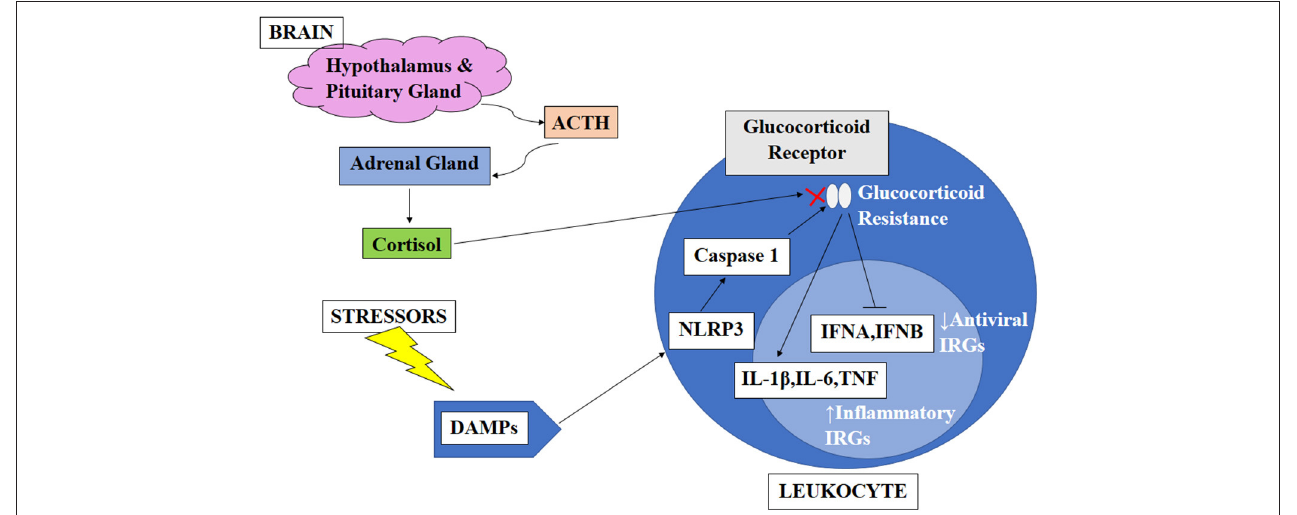
FIGURE 2 | Schematic diagram on the cascading pattern of circadian disruption resulting in glucocorticoid resistance and immunity dysfunction. This figure illustrates the cascading pattern of circadian disruption resulting in glucocorticoid resistance and immunity dysfunction. The brain produces ACTH which caused the adrenal gland to release cortisol which has an anti-inflammatory effect by inducing a decrease in the production of interferon- γ (IFN γ ), interleukin-2 (IL-2), and tumor necrosis factor (TNF). However, in circadian disruption, persistent activation of the HPA axis can induce glucocorticoid resistance of immune cells. Apart from that, psychological and physical stressors trigger the expression of endogenous damage-associated molecular patterns (DAMPs), which in turn activates the NOD-, LRR- and pyrin domain-containing protein 3 (NLRP3) inflammasome. These NLRP3 inflammasomes induce caspase-mediated cleavage of the glucocorticoid receptor, resulting in glucocorticoid resistance. Normally, both inflammatory and antiviral immune response genes (IRGs) are inhibited by cortisol. However, only antiviral IRGs are inhibited in the glucocorticoid resistance state, resulting in decreased expression of antiviral IRGs while increasing the expression of inflammatory IRGs (64).